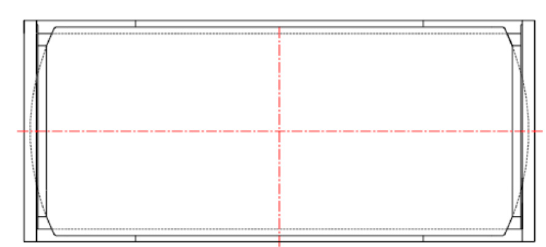
Figure 4. Upper Figure 4. Upper view. Figure 4. Upper view.